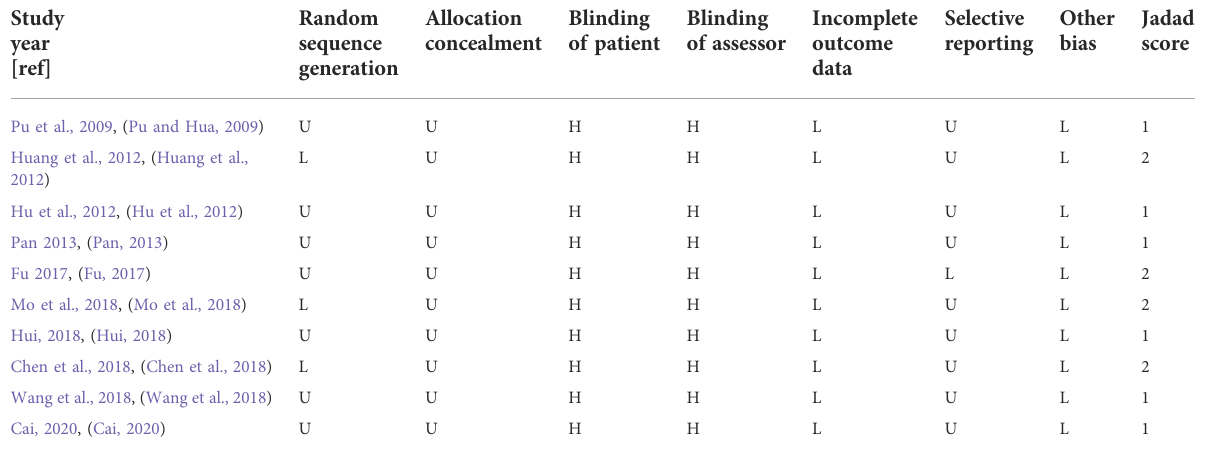
TABLE 4 Risk of bias and quality of the included